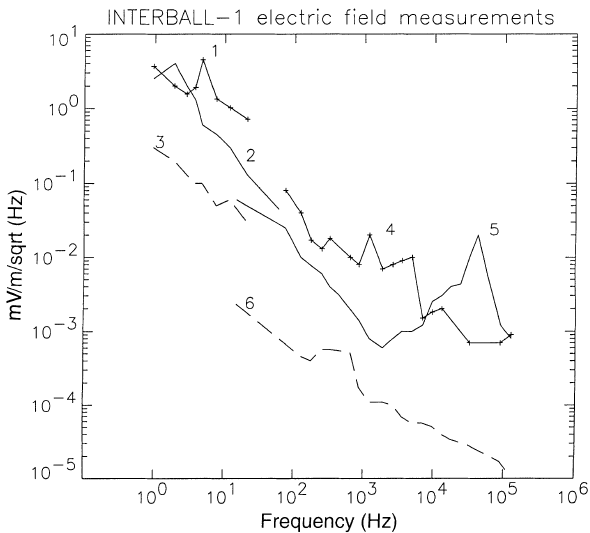
Fig. 3. Noise levels of the electric field sensors. Curve 1: bow shock spectrum (on board FFT); curve 2: bow shock spectrum, measured by the BUD-E experiment of PROGNOZ-8; curve 3: noise spectrum (on board FFT); curve 4: bow shock spectrum (filter bank); curve 5: upstream spectrum (filter bank); curve 6: noise spectrum (filter